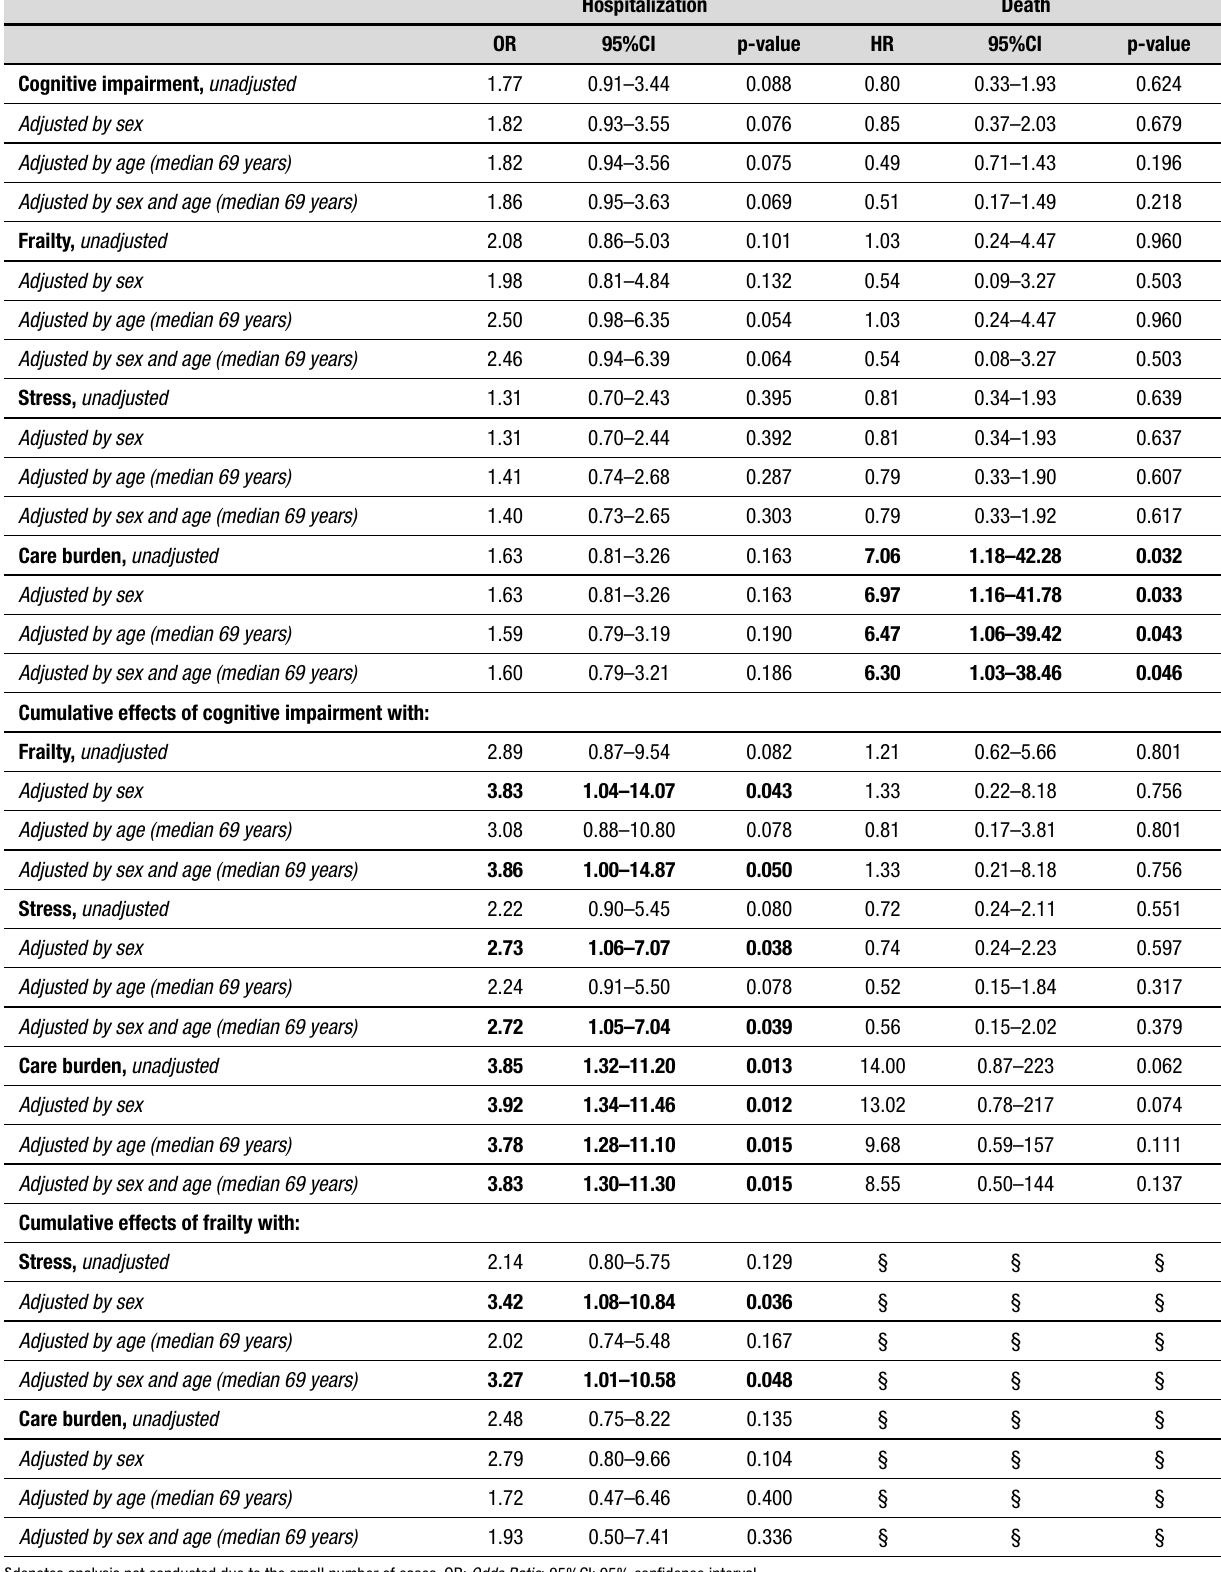
Table 2. Binary regression for hospitalization and Cox regression for mortality of caregivers. São Carlos, Brazil,